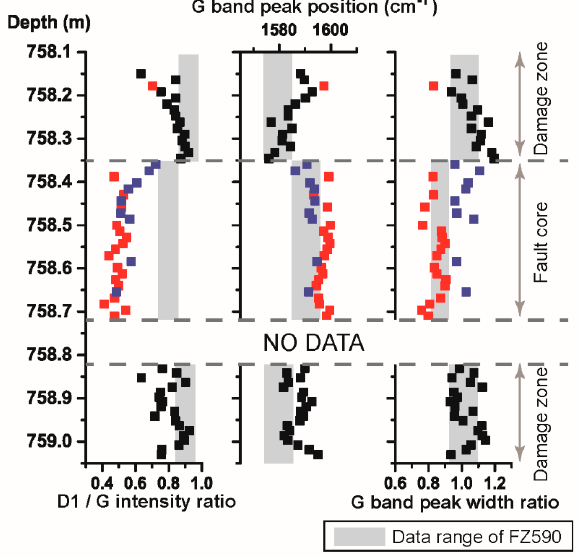
Figure 5. Raman spectra of FZ760 samples across the Longmenshan fault system. Red rectangles indicating the samples containing high R1 value and low G band peak width ratio value with respect to breccia. Blue rectangles indicating the samples containing high R1 value and similar G band peak width ratio value with respect to breccia. Grey rectangles representing the data range of FZ590 by Kuo et al. [21].